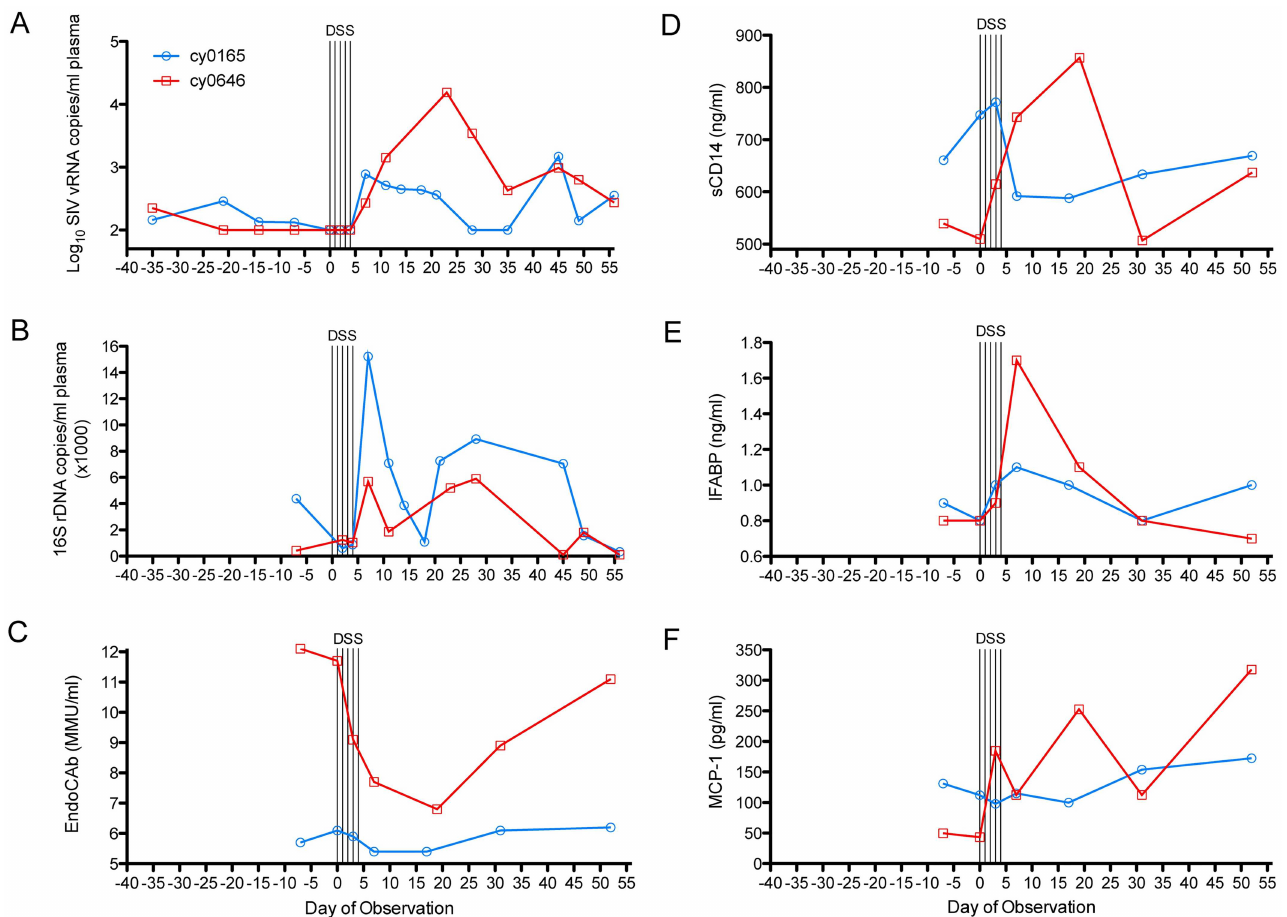
Fig 4. Chemically inducing microbial translocation stimulates multiple host inflammatory processesand increasesplasma viremia and levels of bacterial rDNA. ( A ) Log 10 -transformed plasma SIV load. ( B ) Linearplasma 16S rDNA load. The bacteria-specific host responsewas assessed by monitoringplasma levels of ( C ) EndoCAb and ( D ) sCD14. Plasma IFABP levels ( E ) were used to monitor changes to the integrity of the gastrointestinal epithelium. Generalized inflammation was monitored using plama levels of ( F ) MCP-1. In all panels,5 black vertical lines indicatethe 5-day periodof once-daily treatment with dextran sulfate sodium